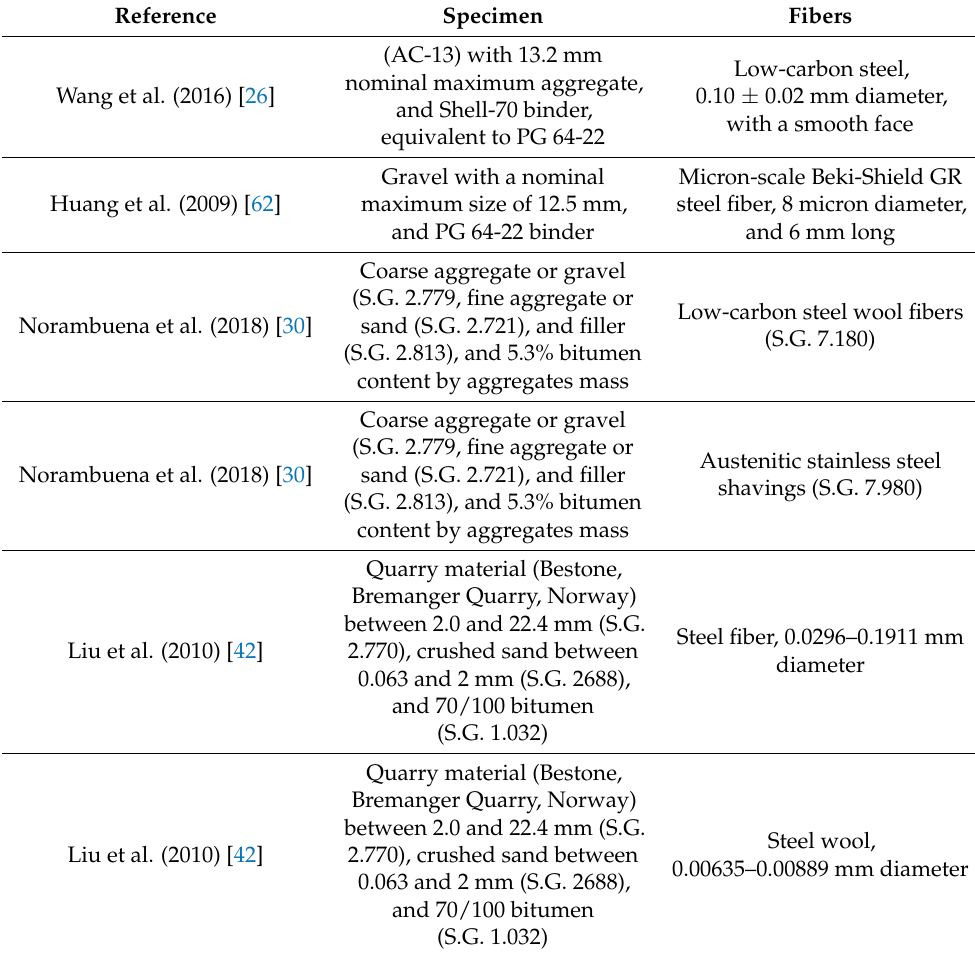
Table 1. Selected experimental studies on the electrical resistivity of fiber-reinforced asphalt.